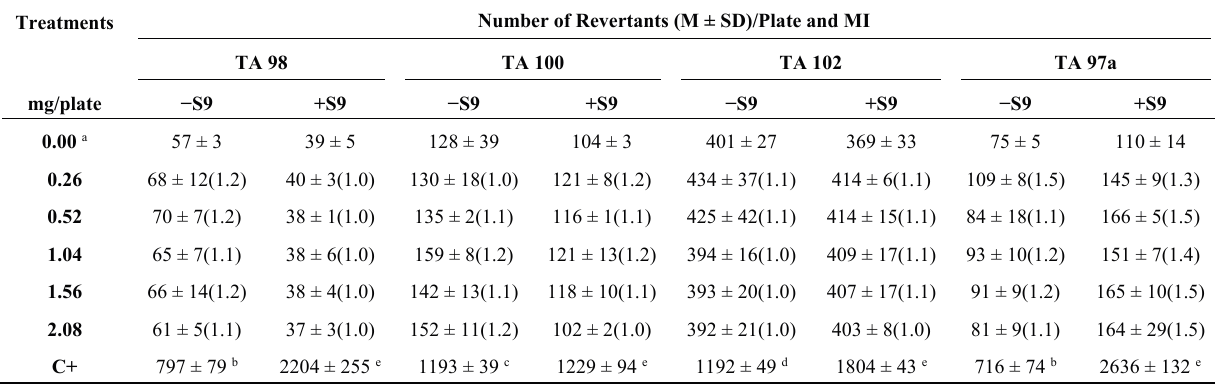
M ± SD = mean ± standard derivation of number of revertants/plate. Negative control: a dimethylsulfoxide (100 μ L/plate). Positive controls (C+): b 4-nitro-o-phenylenediamine (10 µg/plate); c sodium